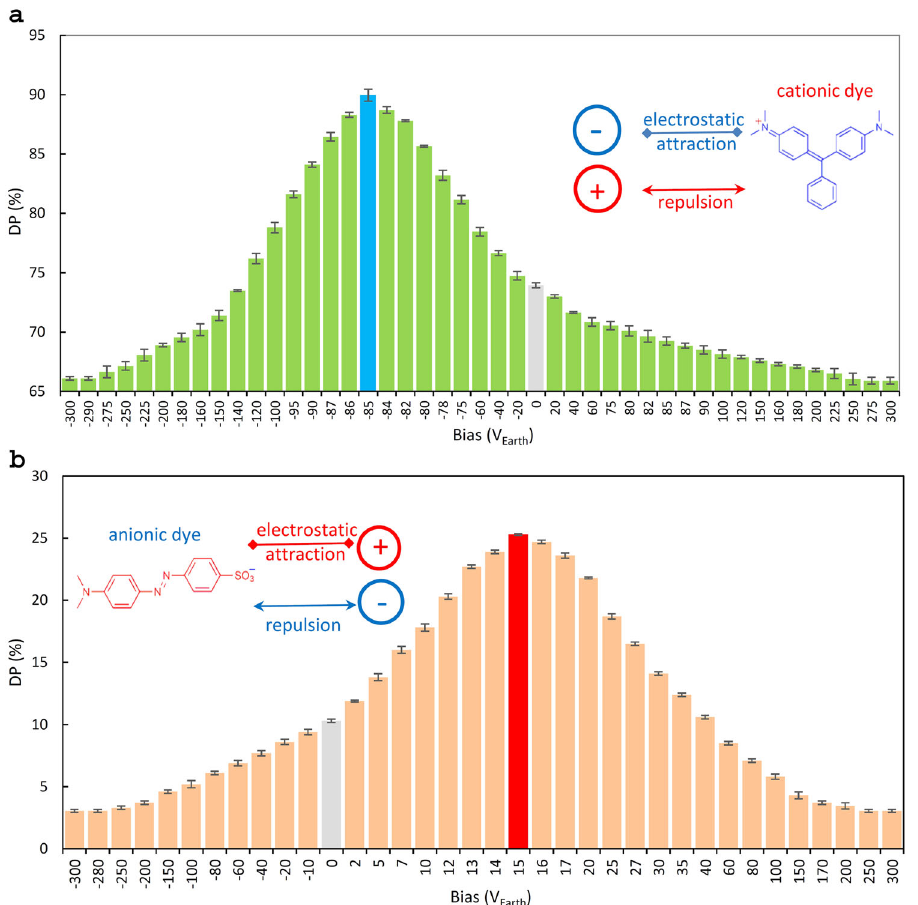
Fig. 4 Electrostatic bias effect on pyrite photoreactor performance. DP “ decolorization percentage ” data plotted for ( a ) cationic malachite green and ( b ) anionic methyl orange dyes (the error bars are standard deviation). The insets are schematic illustration of the electrostatic (attractive/repulsive) forces exerting between ionic dye and polarized/charged